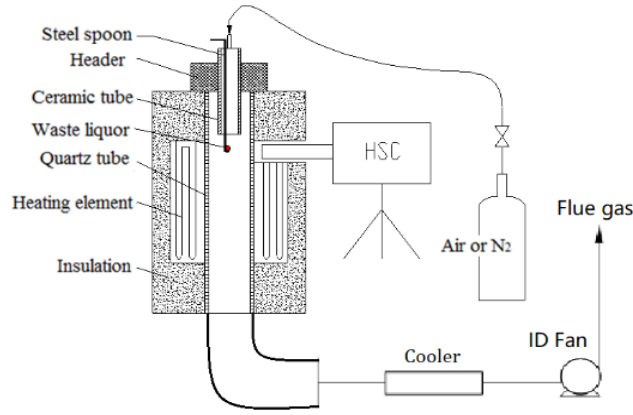
Figure 2. Test system diagram of vertical tube furnace.